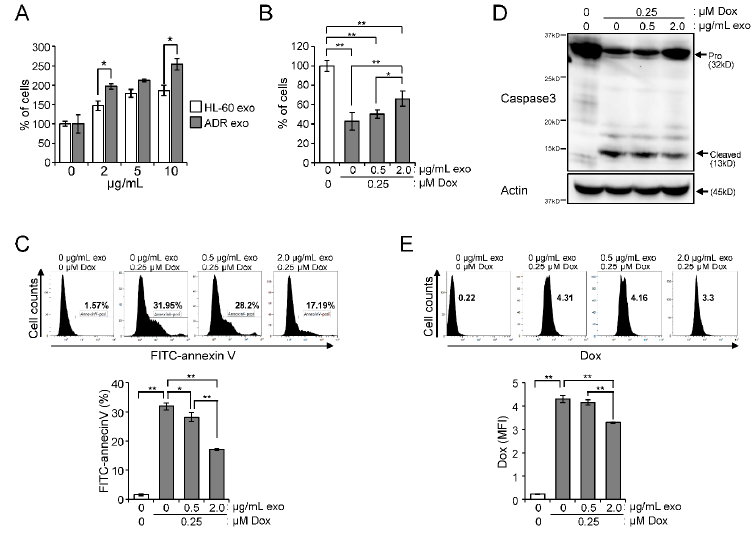
Figure 5. Exosomes purified from HL-60/ADR suppress doxorubicin-induced apoptosis in HL-60 cells. ( A ) HL-60 and HL-60/ADR cells were treated with exosomes extracted from the media of HL-60 (HL-60 exo) or HL-60/ADR cells (ADR exo) at the indicated concentration and cultured in RPMI-1640 supplemented with 5 µ g/mL insulin and 5 µ g/mL transferrin. After 12 h, viable cells were measured by CCK8 assay and represented as percentage of vehicle treatment (0 µ g/ µ L) ( n = 3). ( B – E ) HL-60 cells were pre-treated with ADR exo for 12 h and then treated with doxorubicin (Dox) for 12 h. ( B ) Viable cell numbers were counted after trypan blue exclusion and indicated as percentage of vehicle treatment ( n = 4). ( C ) Cells were stained with FITC-conjugated annexin V and analyzed by flow cytometry ( n = 3). ( D ) Western blot analysis of caspase-3 and actin. ( E ) Dox taken up by cells was analyzed by flow cytometry ( n = 3). Values indicate mean ± SD. * p < 0.05, ** p < 0.005.